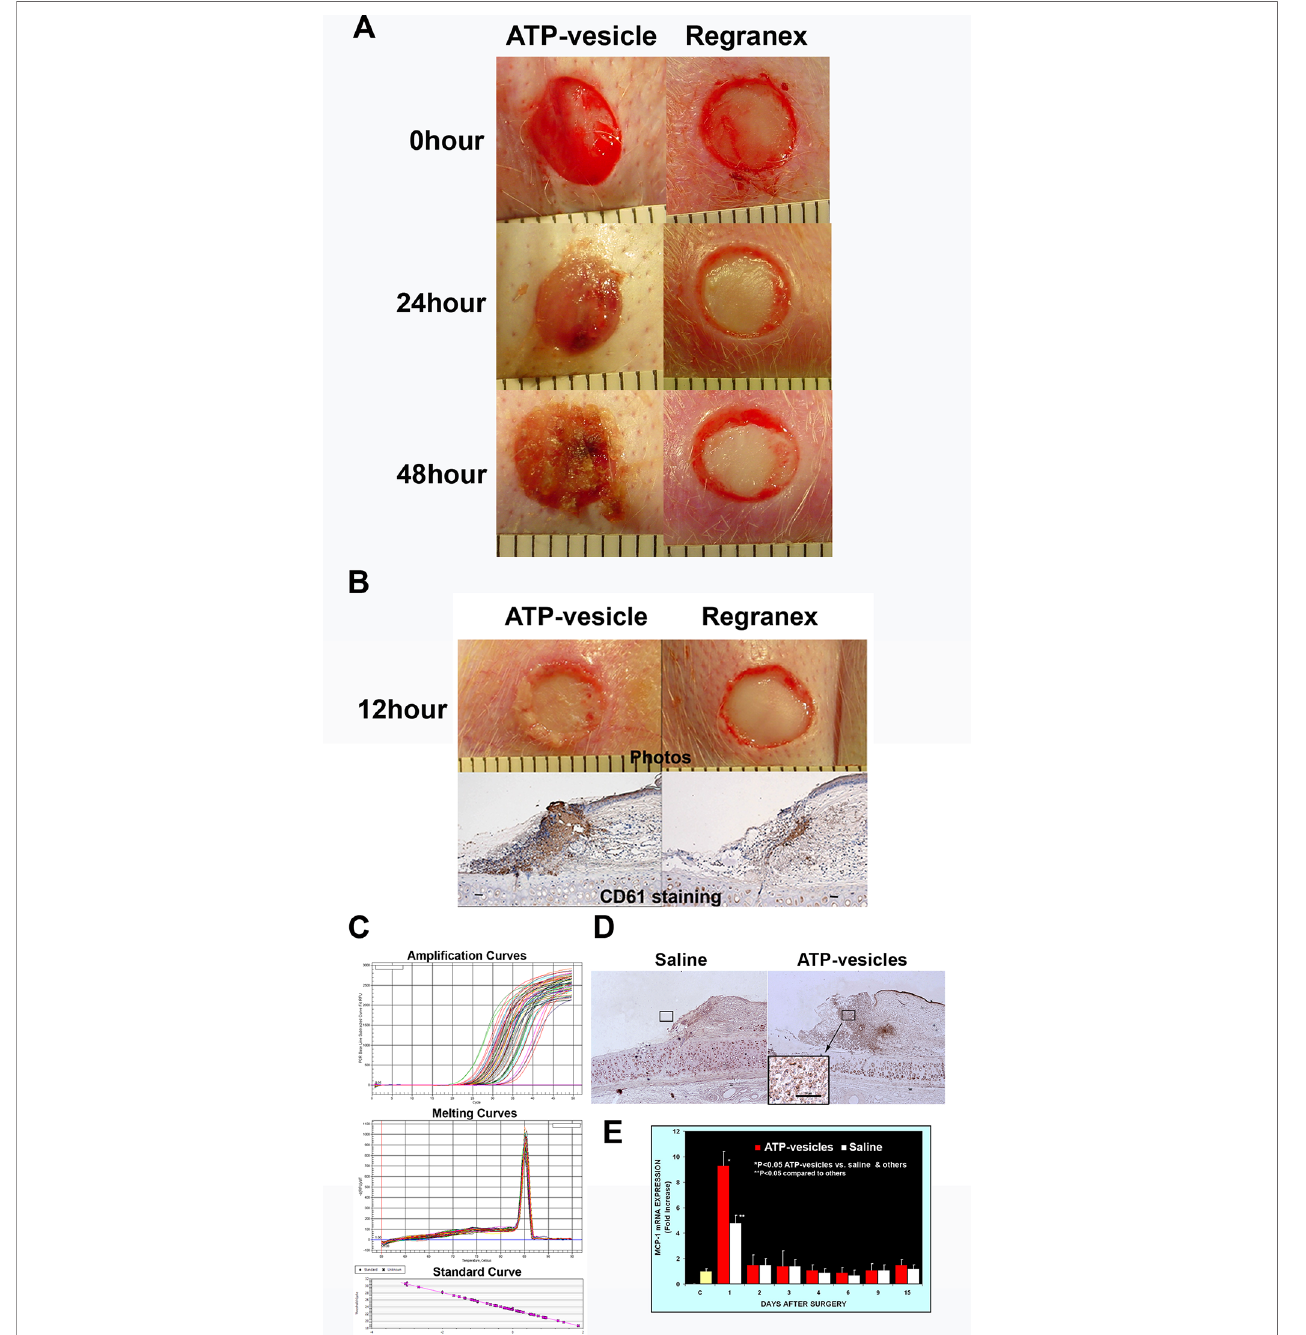
FIGURE 1 | (A) Comparison of early tissue growth in wounds treated with ATP-vesicles and Regranex. Granulation tissue already started to grow within 24 h in the ATP-vesicle – treated wounds while no growth was seen in Regranex-treated wound. (B) Anti-CD61 staining of these wounds shows the presence of platelets with a brown color (scale bar = 50 m m) as early as 12 h of ATP-vesicle treatment. But almost no accumulation of platelets was observed in Regranex-treated wounds. Platelets are the fi rst responders at the wound site for initiating the in fl ammation and healing process before granulation tissue formation. Note: Regranex is a recombinant human platelet-derived growth factor, so it shows some immunoreactivity with CD61 in the control wounds. (C and E) Comparison of MCP-1 expression in wounds from day 1 to day 15 post surgery. Real-time PCR was performed with an IQ5 Cycler (Bio-Rad). Data shown are the mean ± SD of four to six different wound tissues, with triplicate assays for each sample. Normal rabbit ear skin was used as a baseline control (C). *Signi fi cantly different when compared with both the saline treated control group and the baseline control, p < 0.05. **Signi fi cantly different when compared with the baseline control only, p < 0.05. (D) Immunohistochemical comparison of wounds treated with ATP-vesicles and normal saline. Anti-MCP-1 immunoreactivity was higher in the ATP-vesicle – treated wounds than in the saline – treated wounds. The brown color indicates positive immunostaining (scale bar = 50 m m).